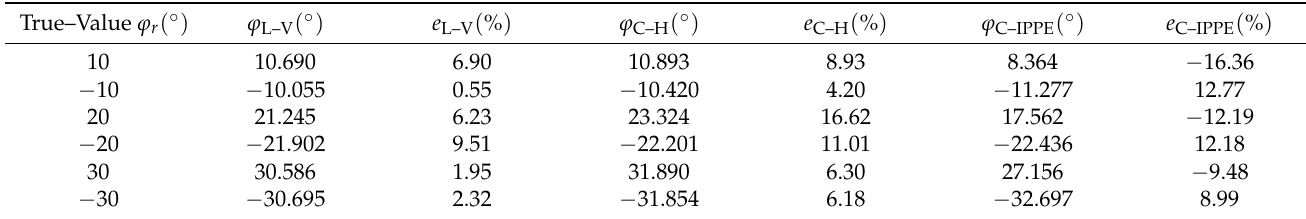
Table 3. Measurement results of rotation angle ϕ about the Z C axis.